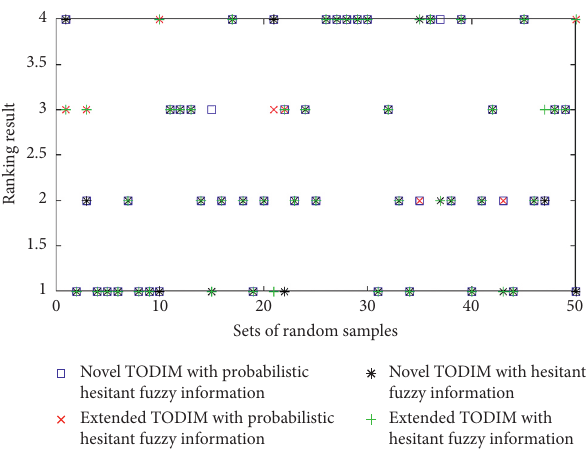
Figure 10: Ranking results of the alternative A